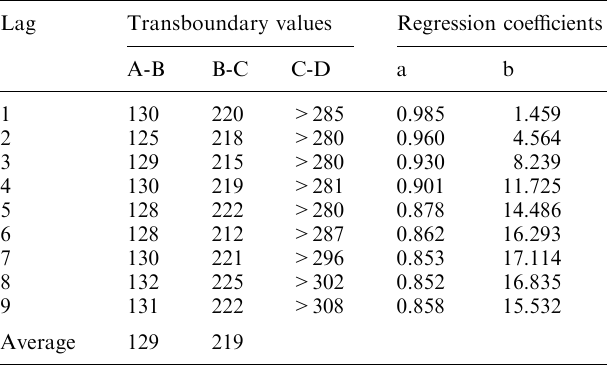
Table 1. Cluster regression boundaries and coe(cid:129)cients Lag Transboundary